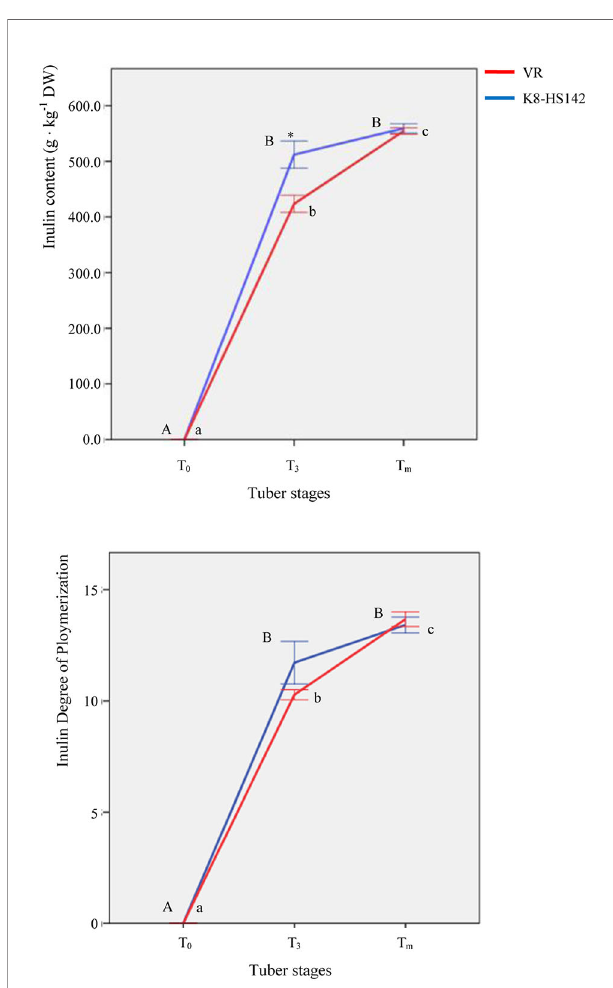
FIGURE 3 | Inulin content and degree of polymerization (DP) in tubers of Helianthus tuberosus “ VR ” and “ K8-HS142 ” clones. Signi fi cantly different values ( p < 0.05) at different stages in the same clone are labeled with different letters (lowercase for “ VR, ” uppercase for “ K8-HS142 ” ) and those between clones at the same stage with *. The bar indicates ±1 standard